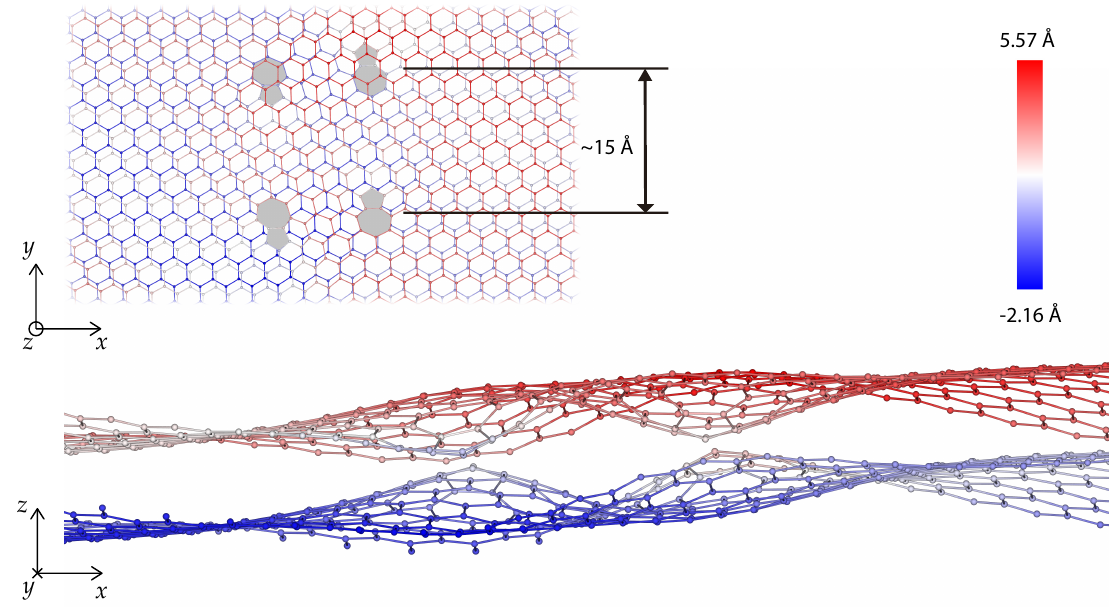
Figure 15. Top ( top ) and front ( bottom ) view of a bilayer arrangement with one n = 9 dipole in each layer, separated 15 Å. The color code indicates the out of plane position of atoms.